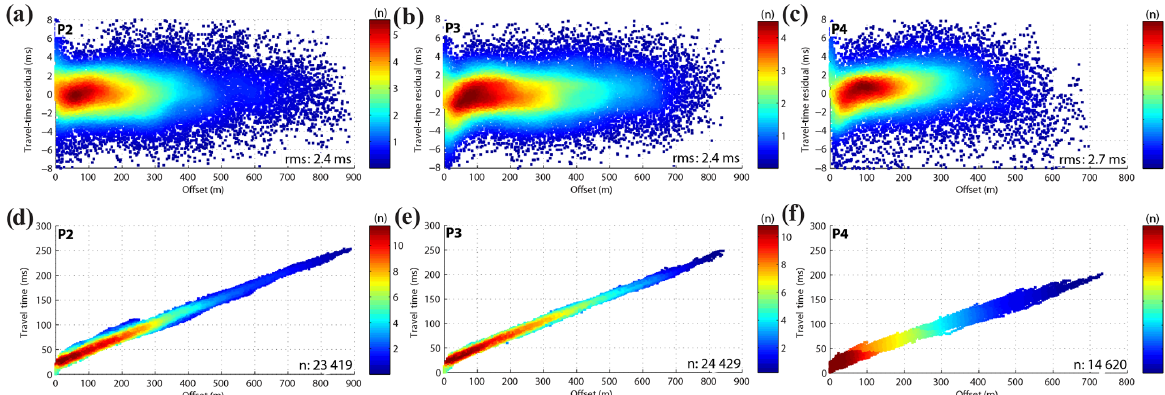
Figure 8. Plots of the travel-time residuals (rms misfit) obtained after eight iterations for (a) profile 2, (b) profile 3 and (c) profile 4. The first picked breaks as a function of offsets along profiles 2–4 are shown in panels (d) – (f) , respectively. Note that profile 4 is shorter than profiles 2 and 3. Different colors represent different data density.